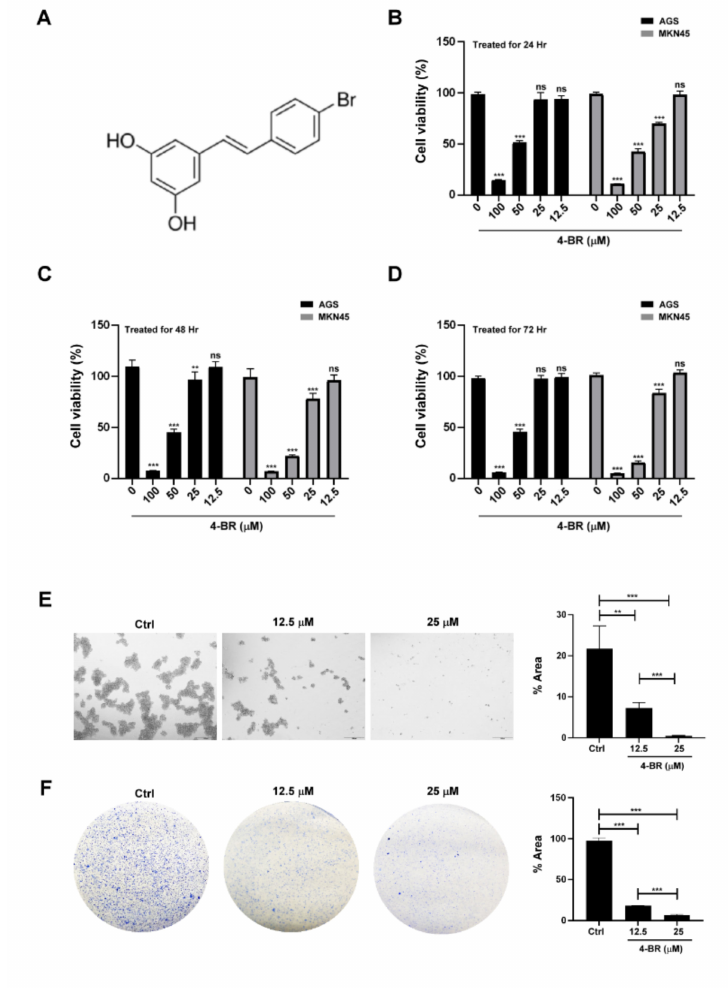
Figure 1. 4-BR reduced cell viability and stemness capacity in human gastric cancer cells. ( A ) Structural formula of 4-BR. ( B ) MKN45 and AGS were treated with various doses of 4-BR (0, 12.5, 25, 50, and 100 µ M) for 24, ( C ) 48, or ( D ) 72 h. ( E ) The 4-BR treatment limited the sphere formation ability in MKN45 (with light microscopy at × 40). ( F ) The 4-BR treatment suppressed the colony formation ability in MKN45 (with light microscopy at × 10). Data are presented as the means ± standard error; n ≥ 3 independent experiments. Student’s t test: ** p < 0.01, *** p <